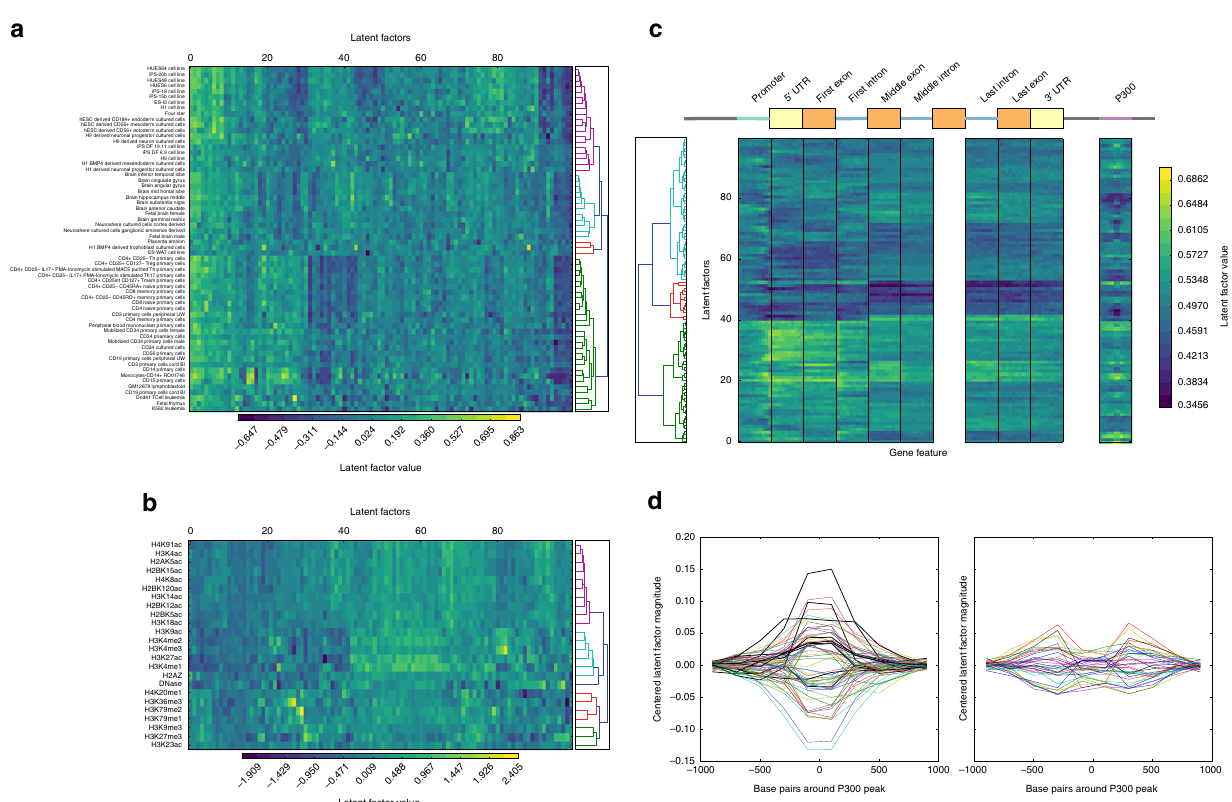
Fig. 3 The model parameters can distinguish among elements in each tensor dimension. Plots show the values (or average values) for 100 latent factors from one of the models trained for this manuscript, and that these values show patterns that distinguish among cell types, assays, and genomic elements. a Hierarchical clustering of the cell types, based on cell type factor matrix values, shows that similar cell types tend to cluster together. This is a subset of cell types; for a clustering of all cell types see Supplementary Fig. 9. b Hierarchical clustering of the assays, based on assay factor matrix values, shows that similar assays tend to cluster together. c Average values from the genome-factor matrix show different patterns at different parts of the gene, and P300 peaks called from ENCODE data. d Average values from the genome factor matrix, for each latent factor, plotted as a line spanning the region ±1 kb around the center of P300 peaks. Parameter values are centered at zero and plotted based on whether they show the highest magnitude at the peak (left, 64 latent factors) or fl anking the peak (right, 36 latent